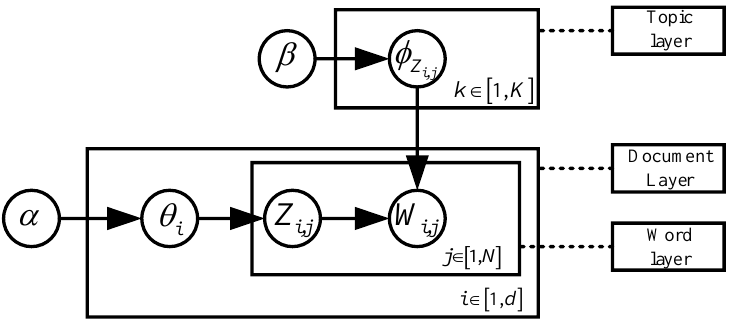
Figure 2. The Process of the LDA topic model.